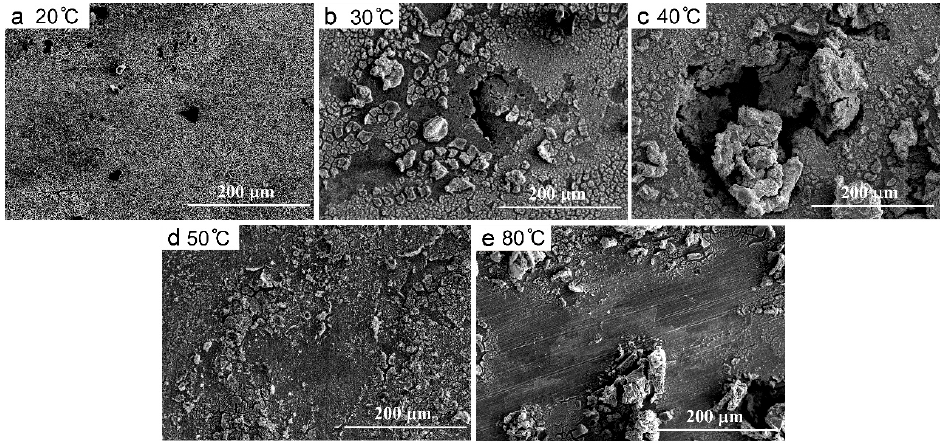
Figure 6. Morphologies of the corroded surfaces at 20 °C ( a ), 30 °C ( b ), 40 °C ( c ), 50 °C ( d ), and 80 °C ( e ).